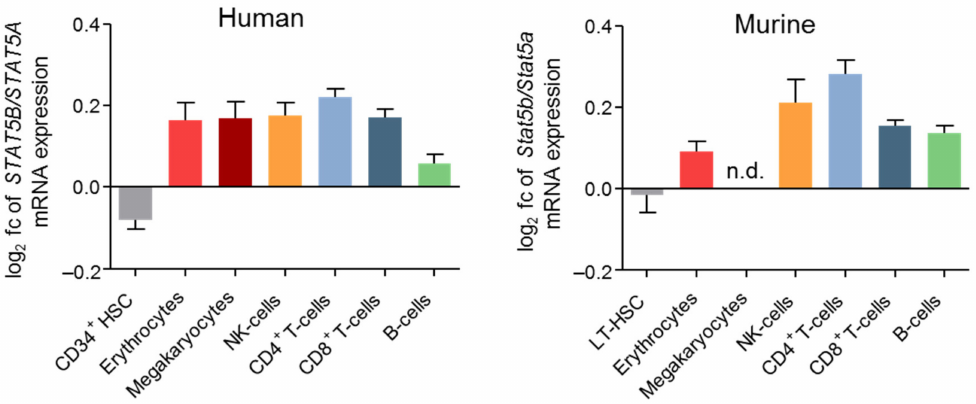
Figure 2. STAT5A and STAT5B mRNA expression levels in hematopoietic cells. Log2 fold change (fc) of STAT5B / STAT5A mRNA expression ratio of human (left) or murine (right) hematopoietic cells [77] using the human probes #212550_at, 212549_at, and 203010_at, and the murine probes #1421469_a_at and 1422103_a_at. (n.d., not